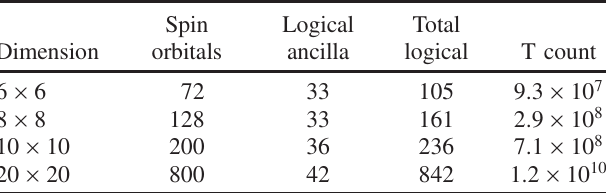
TABLE IV. Resources required for quantum simulation of a planar Hubbard model with periodic boundary conditions and spin, as in Eq. (56). The dimension of the system indicates how many sites (spatial orbitals) are on each side of the square model. The number of system qubits is thus twice the number of spatial orbitals. The number of logical ancillae is computed as Eq. (64). Finally, the number of T gates is computed using Eq. (63), which assumes that u=t ¼ 4 and Δ E ¼ t= 100 . The first three problem sizes in the table are near the classically intractable regime. Spin Dimension